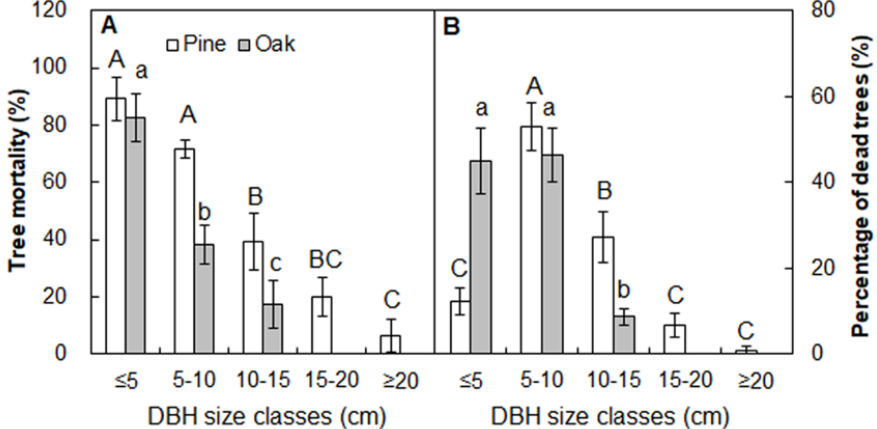
Figure 7. Tree mortality ( A ) and the percentage of dead trees ( B ) in the burned plots by 5 cm diameter at breast height (DBH) class. Different letters indicate significant differences between treatments at p < 0.05. Values are presented as the means ± standard error.